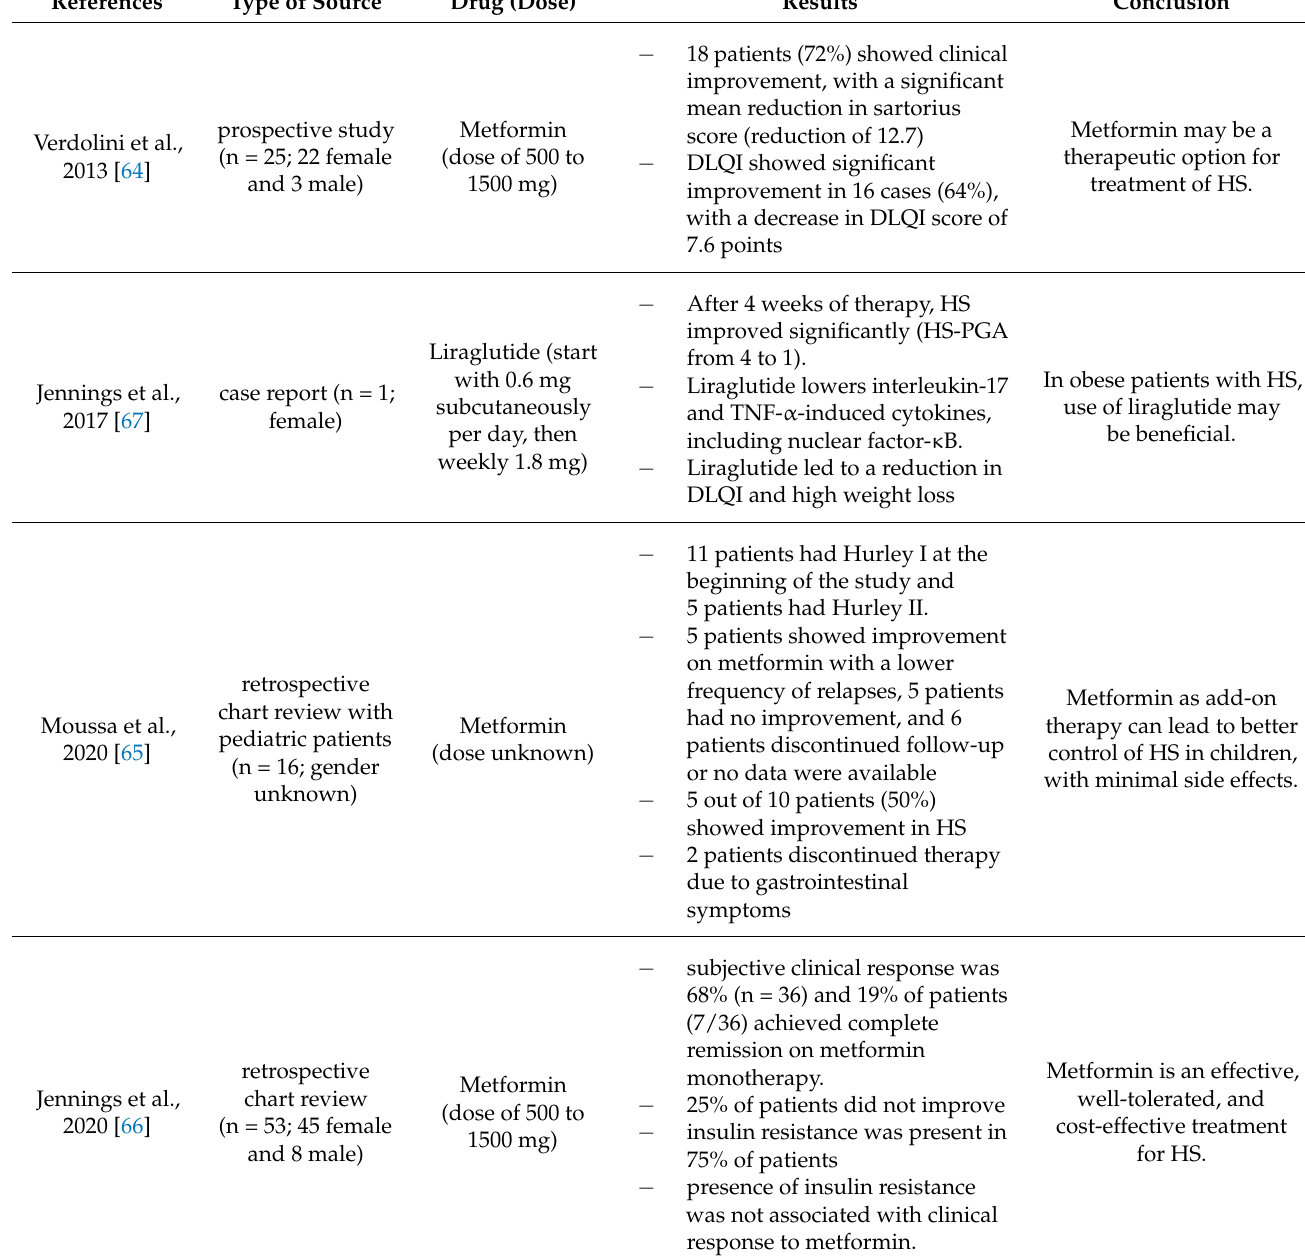
Table 7. Current findings about antidiabetic drugs metformin (enhancement of the insulin effect)